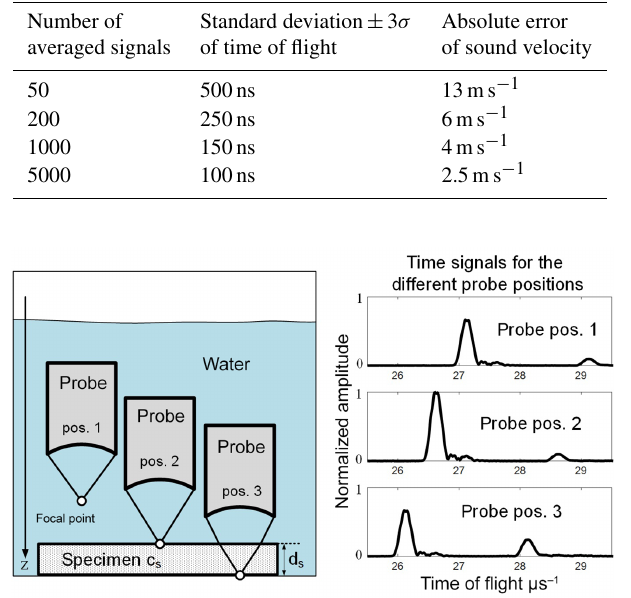
Figure 5. Principle drawing for the combined measurement of thickness and sound velocity by means of a focusing